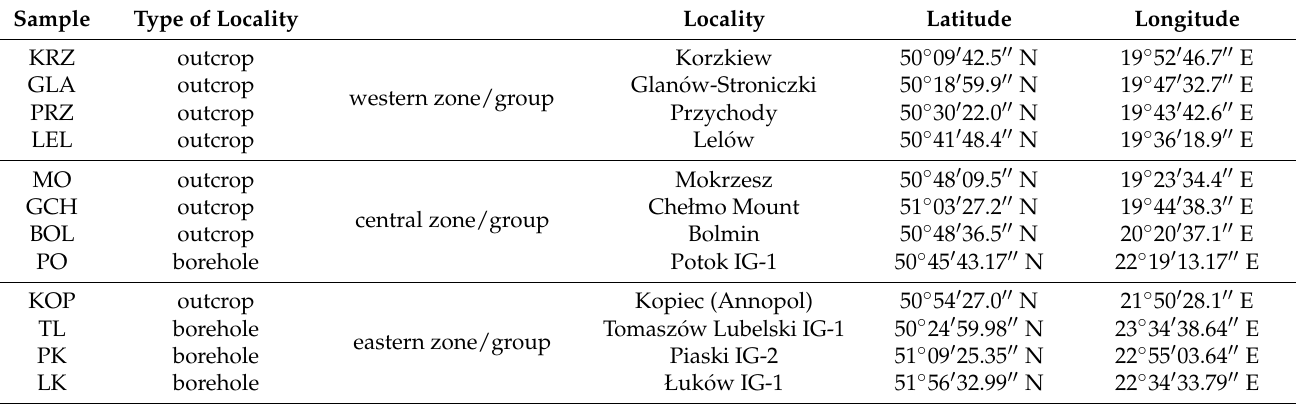
Table 1. GPS coordinates of the examined